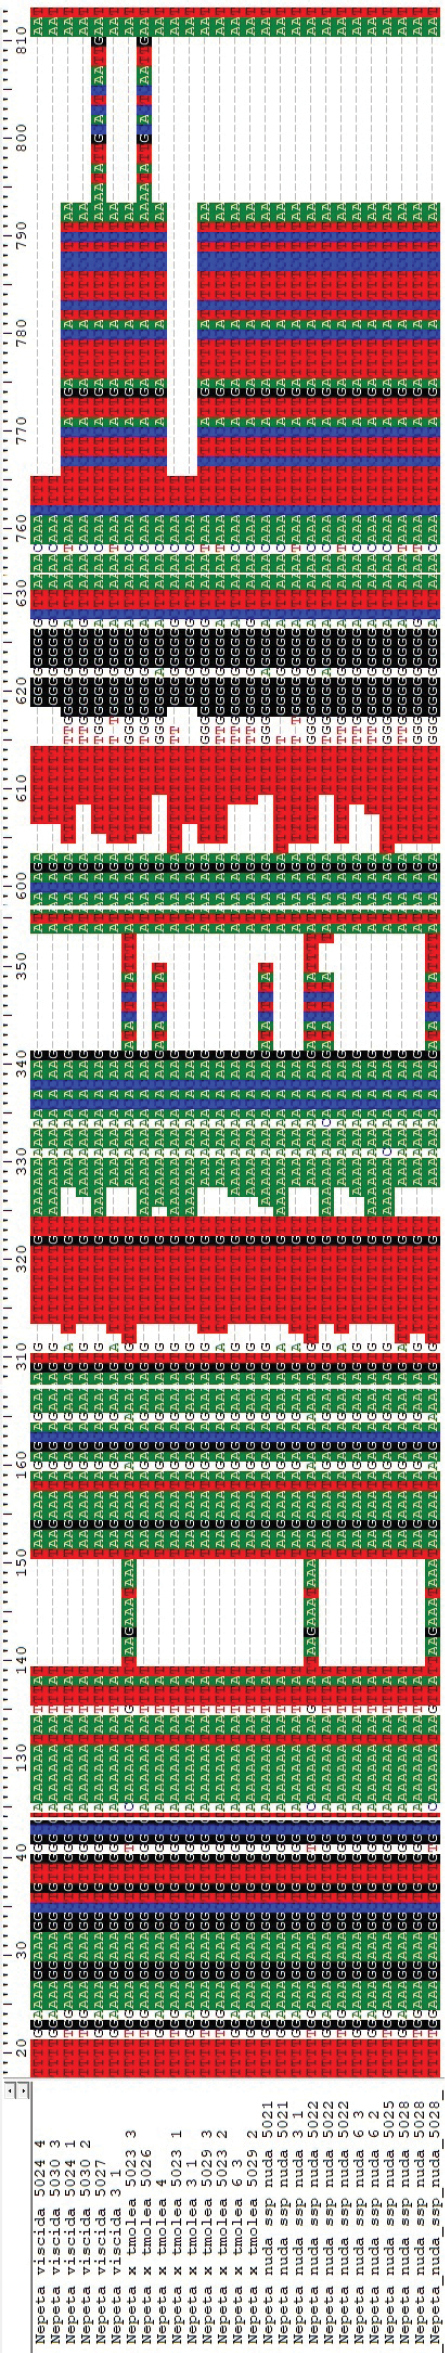
Insertions, deletions and single nucleotide polymorphisms based on rpl32-trnL sequences.